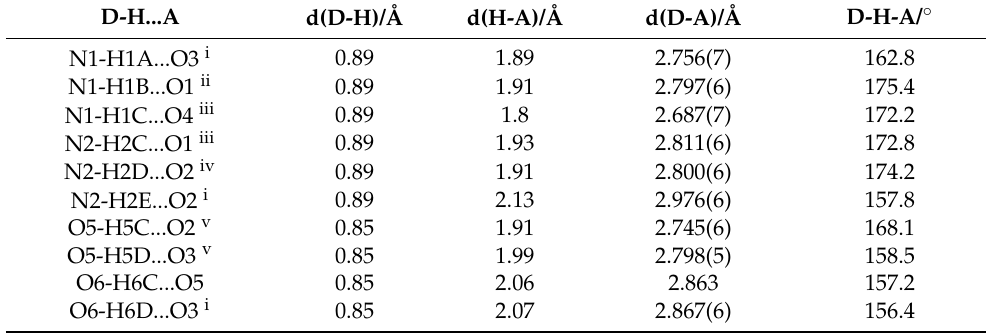
Table 4. Hydrogen Bonds for 3C16.